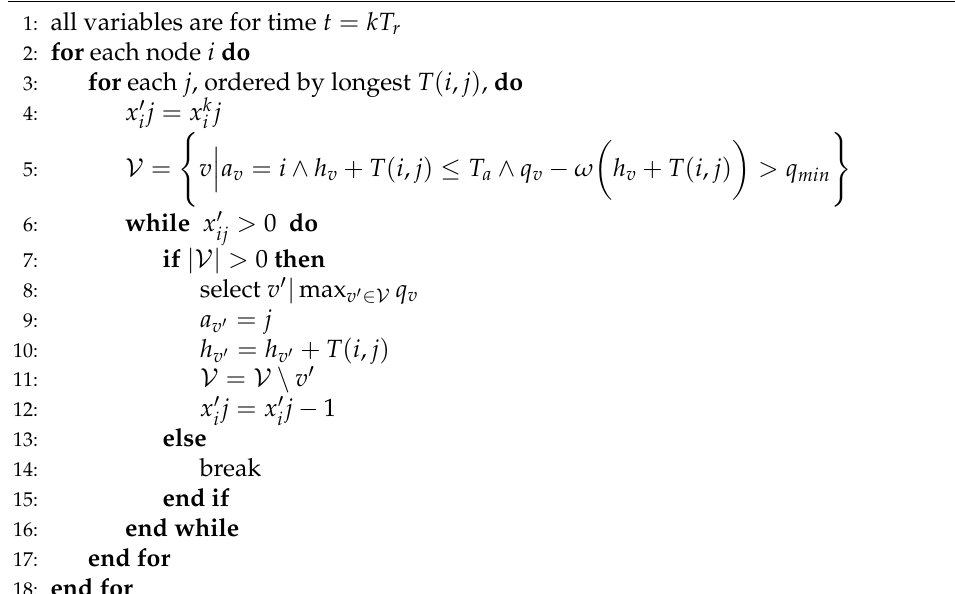
Algorithm 1 Assignment of vehicles to relocation tasks for k -th call to relocation